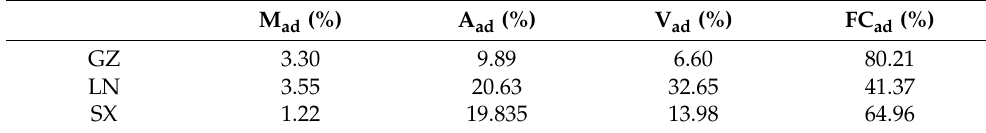
Table 1. Samples’ analytical